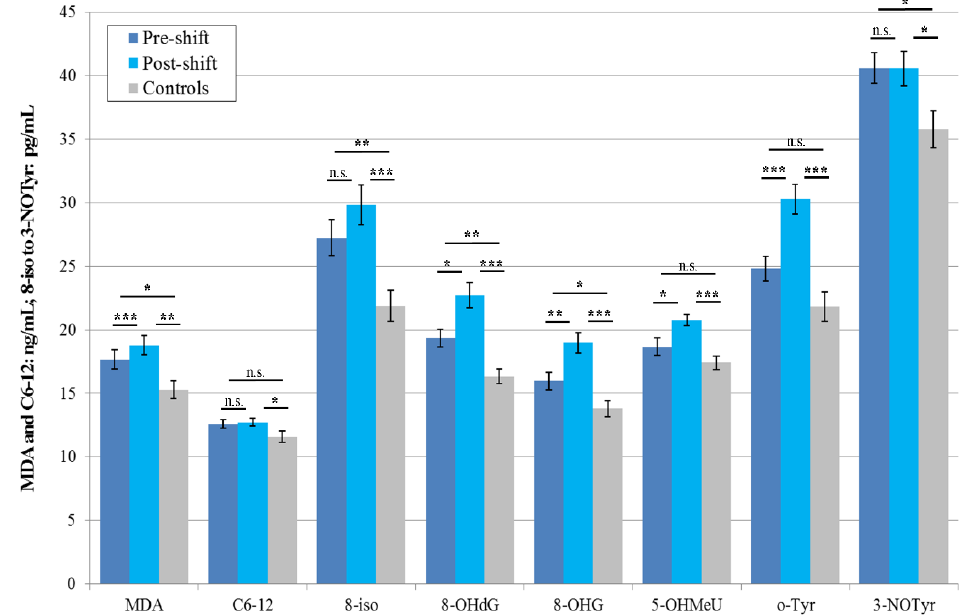
Figure 1. Mean and standard deviations of the levels of eight oxidative stress markers in the EBC of 20 workers (machining) and 20 control subjects (morning) in 2017, * p < 0.05, ** p < 0.01, *** p < 0.001, n.s. = not significantly different, EBC = exhaled breath condensate, MDA = malondialdehyde, C6-12 = aldehydes C6-12, 8-iso = 8- iso -prostaglandin F2α (8-isoprostane), 8-OHdG = 8-hydroxy-2-deoxyguanosine, 8-OHG = 8-hydroxyguanosine, 5-OHMeU = 5-hydroxymethyl uracil, o-Tyr = o - tyrosine, 3-NOTyr = 3-nitrotyrosine.